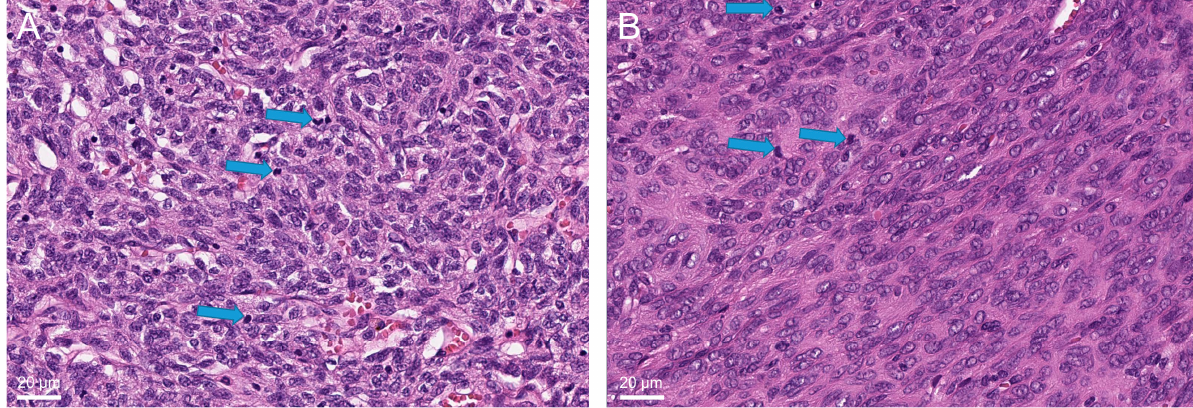
Figure 5. Lymphocyte-poor (type A-like) AB-thymoma (hematoxylin and eosin staining); sparse intratumorous lymphocytes are marked exemplarily with arrows (( A ), case 249832, ( B ), case 249834). In such cases, the distinction from type A-thymoma is difficult and arbitrary.